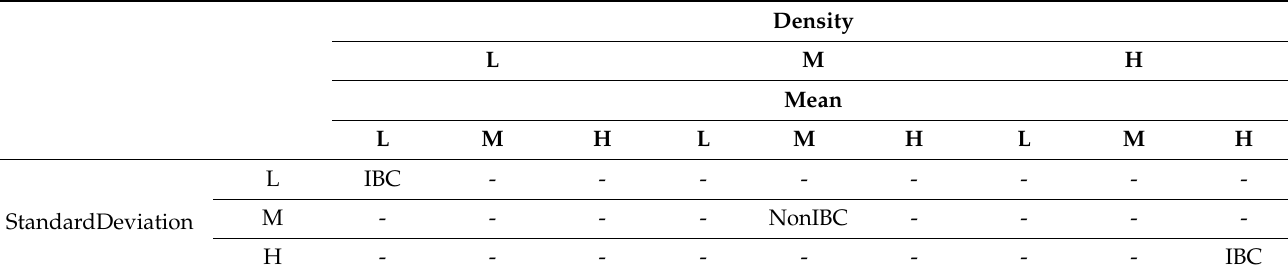
Figure 8. Three inputs proposed membership functions of the Type-1 fuzzy system. Table 2. Fuzzy rules in the proposed Type-1 and Type-2 classifiers.